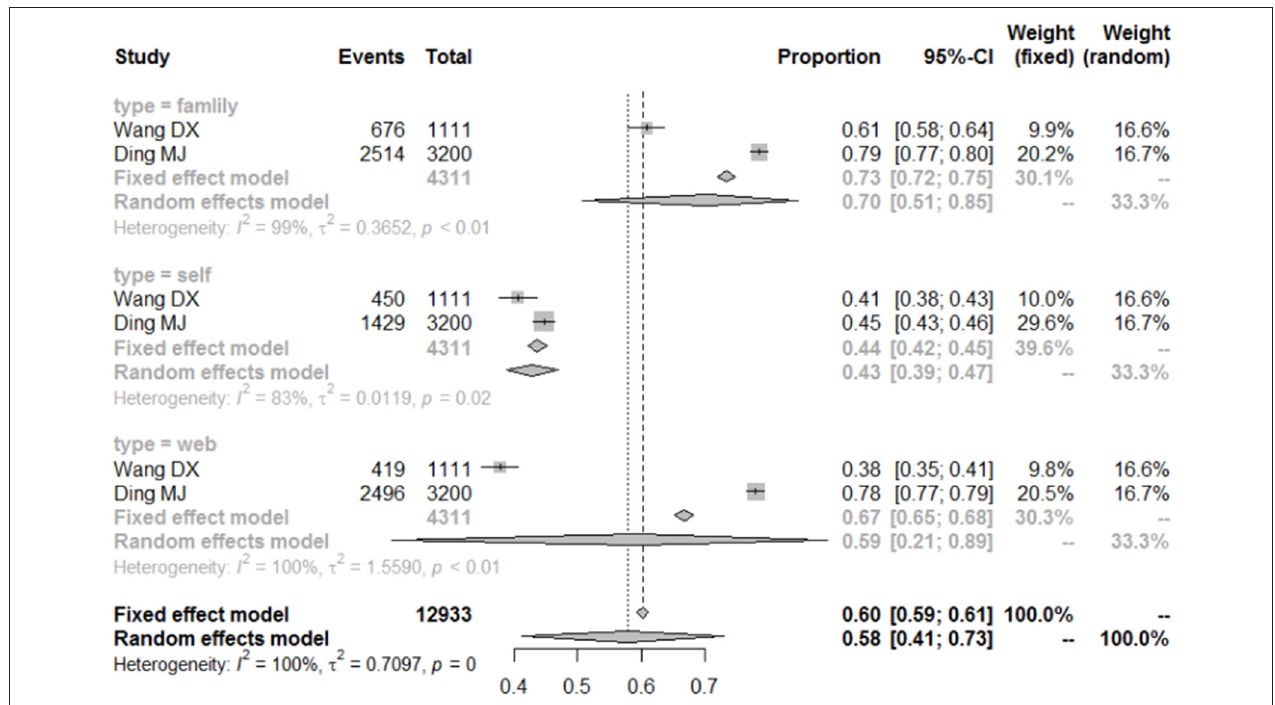
FIGURE 7 | Forest plot of the coping styles of depressed college students.